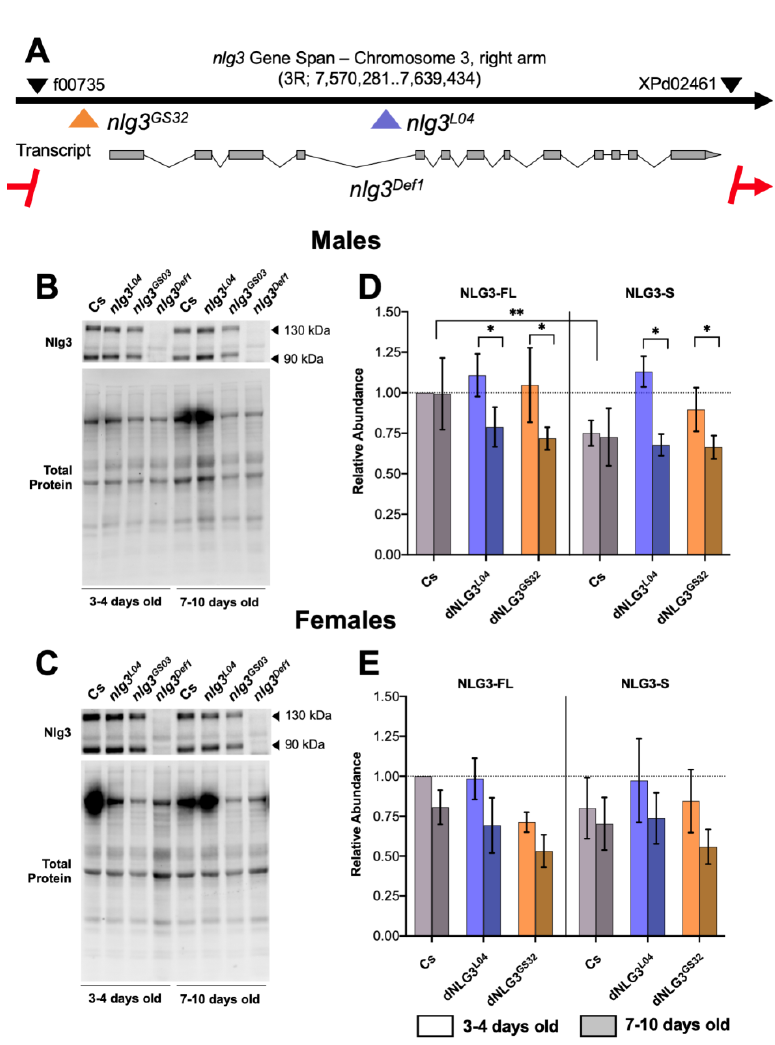
Figure 1. Map of neuroligin 3 ( nlg3 ) mutations used in this study, and their effects on Nlg3 protein level. ( A ) Gene map of nlg3 displaying insertion and deletion sites for corresponding mutants. The black arrow represents gene span. Grey squares in the transcript represent exons and lines indicate